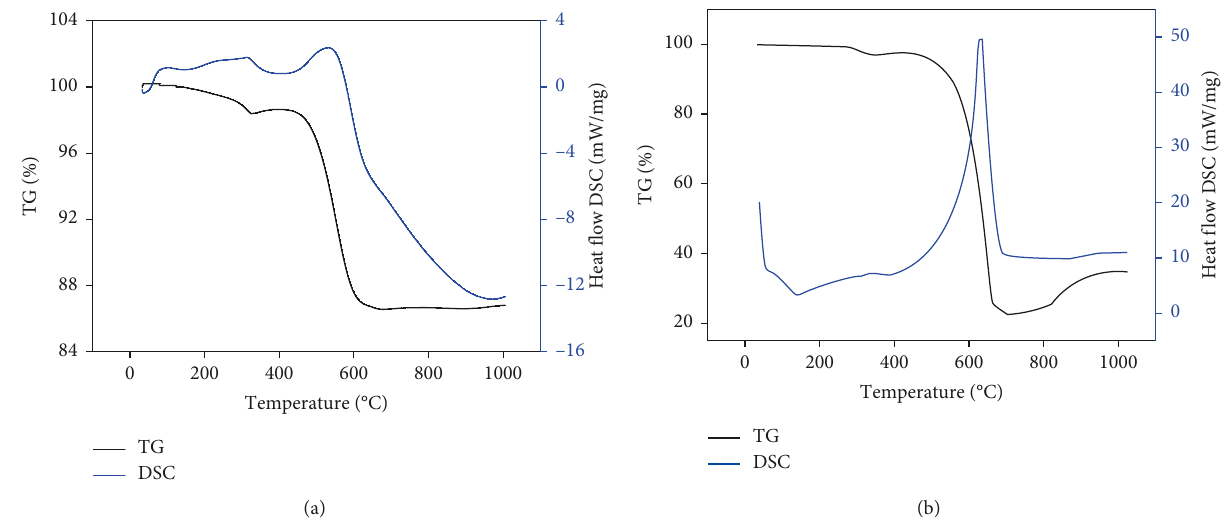
Figure 8: TG-DSC profile of LaFe 0.5 Ni 0.5 O 3 (a) and LaFe 0.3 Ni 0.7 O 3 (b) after the 80h stability test in